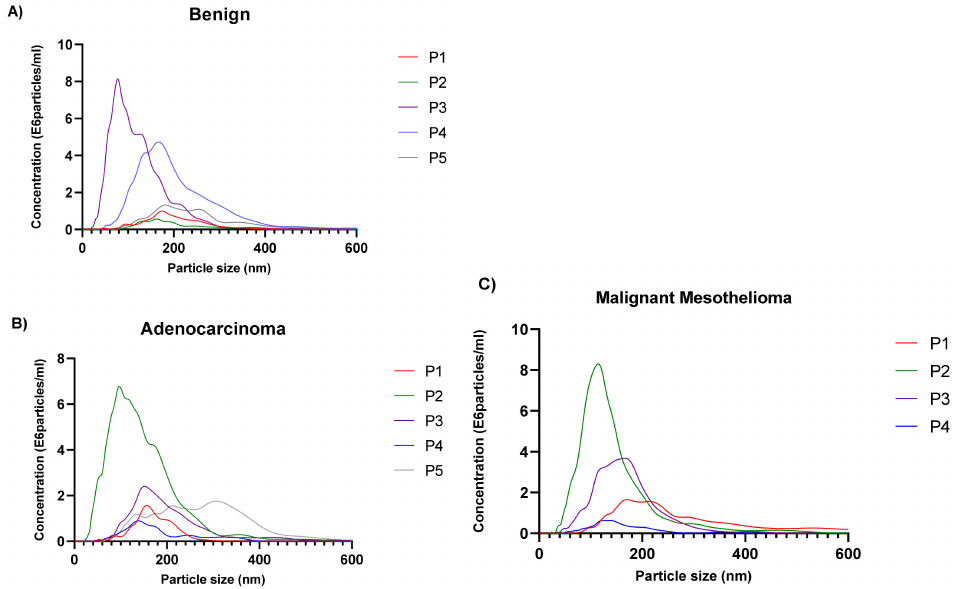
Figure 2. Exosome’s size and concentration measured by NTA. Size distribution plots from five benign pleural effusions (0.7 × 10 6 to 8.7 × 10 6 particles/mL) ( A ), five adenocarcinoma patients (0.7 × 10 6 to 7.4 × 10 6 particles/mL) ( B ) and four malignant mesothelioma patients (0.6 × 10 6 to 8.7 × 10 6 particles/mL) ( C